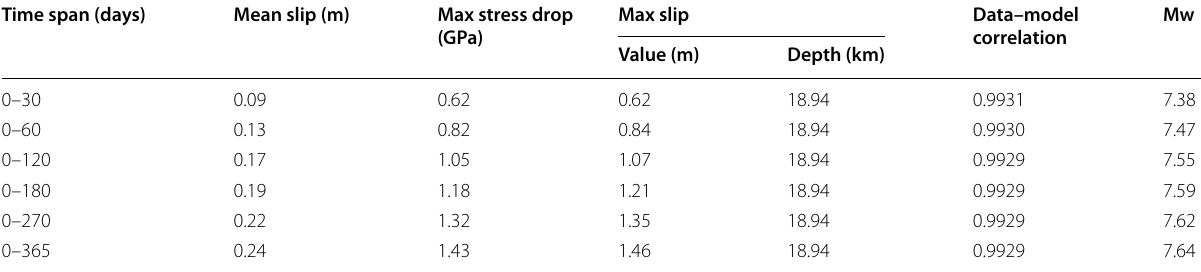
Table 2 The result of postseismic slip inversion of 6 time periods Time span (days) Mean slip (m) Max